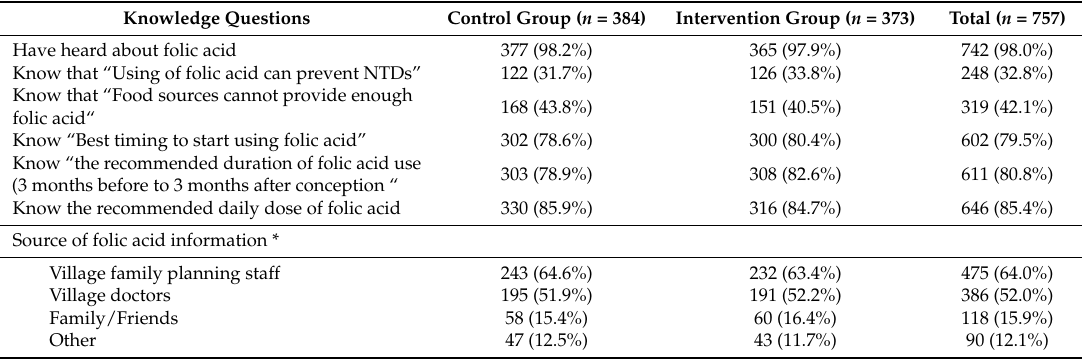
Table 1. Awareness and knowledge of folic acid among the rural women at